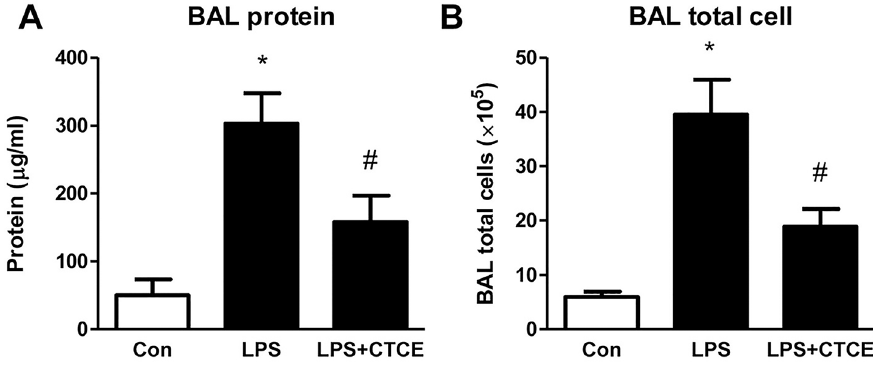
Figure 6. CTCE decreased BAL protein levels and total cells in LPS-induced ARDS. CD-1 mice were given an intratracheal instillation of LPS (25 μg in 75 μL of saline) and treated with CTCE at 2 h post–LPS instillation. BAL protein levels (A) and total cell counts (B) were determined. * p < 0.05 compared with control group, # p < 0.05 compared with LPS groups. N = 6–10 mice/group.